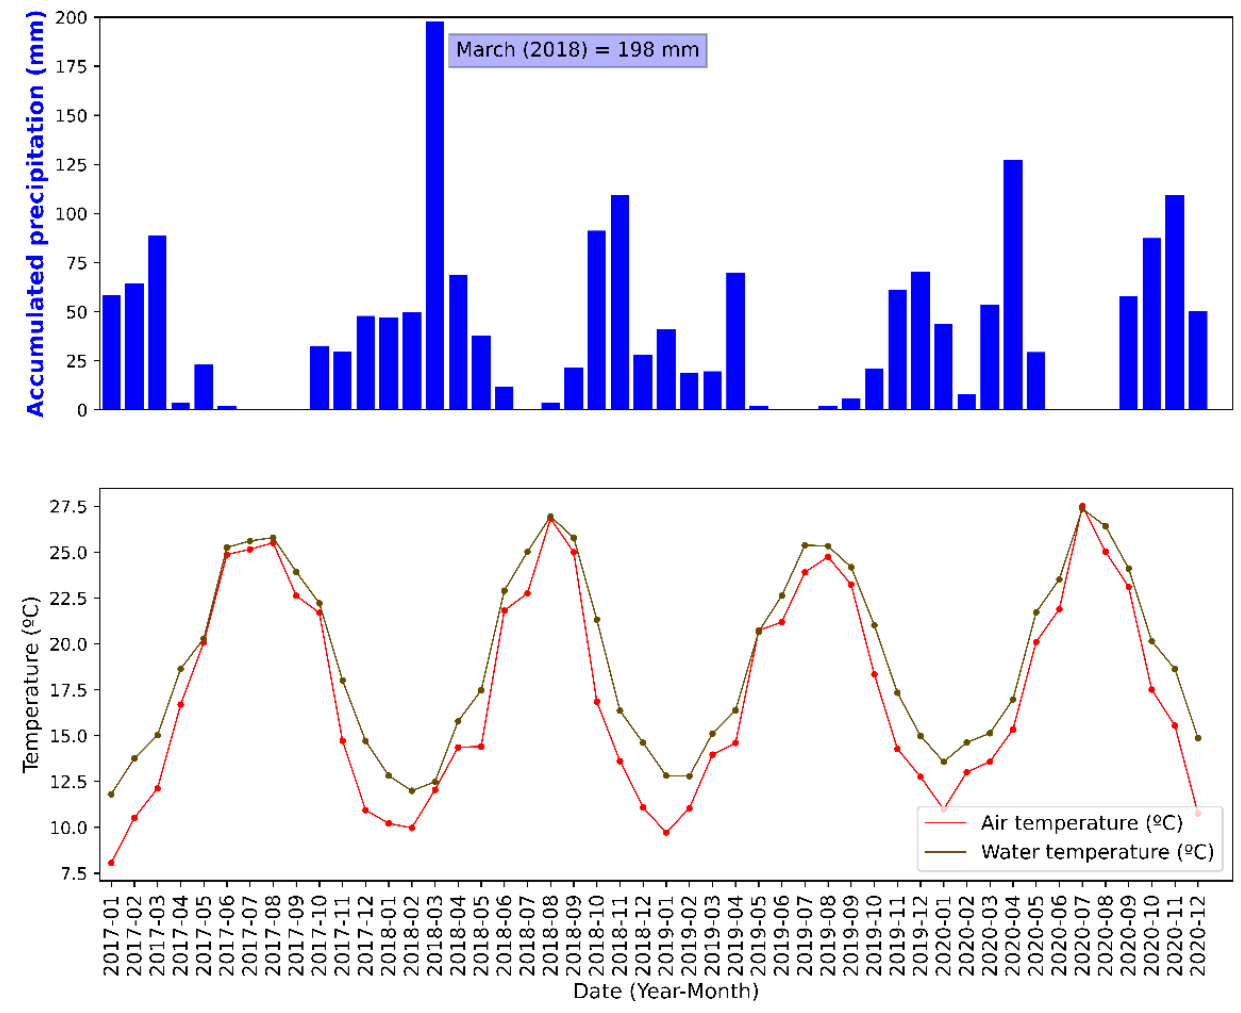
Figure 2. Monthly accumulated precipitation (above) and monthly average of air/water temperatures (below), in the Alqueva reservoir.